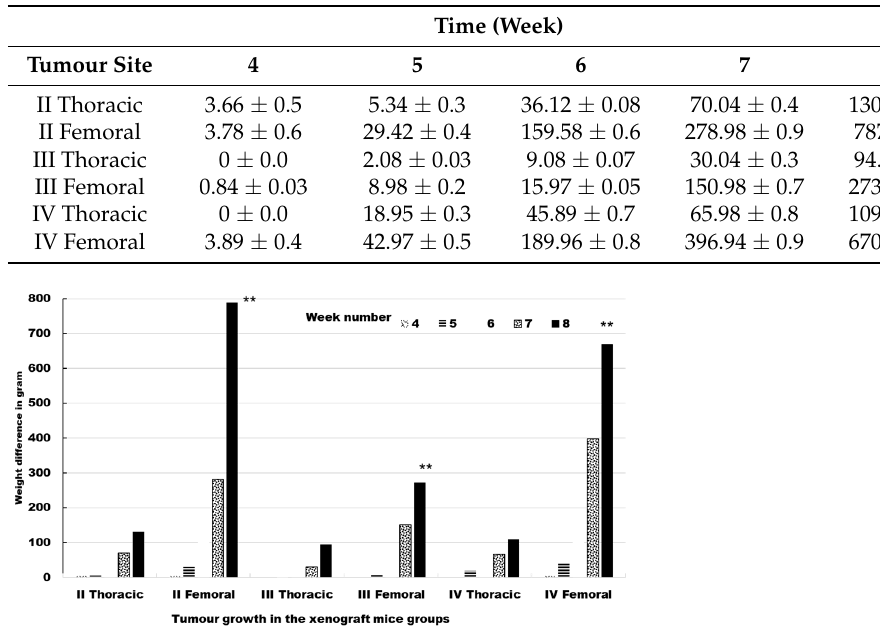
Figure 8. Tumor growth in the xenograft mice groups. Right injected thoracic and femoral sites. The number of mice with tumors is 10 with 4 tumors per mouse. Data represent the mean ± SD. ** p < 0.001 as compared to controls. Table 1. Xenograft tumor growth: tumor volume in mm 3 in all groups and 10 mice per group. Four sites were injected in each mouse. Left sites relating to tumors are summarized in Table 1. In groups II, III, and IV, all of the injected tumours grew, which allowed us to assess 120 tumours in total. Data is expressed as mean ± SD.